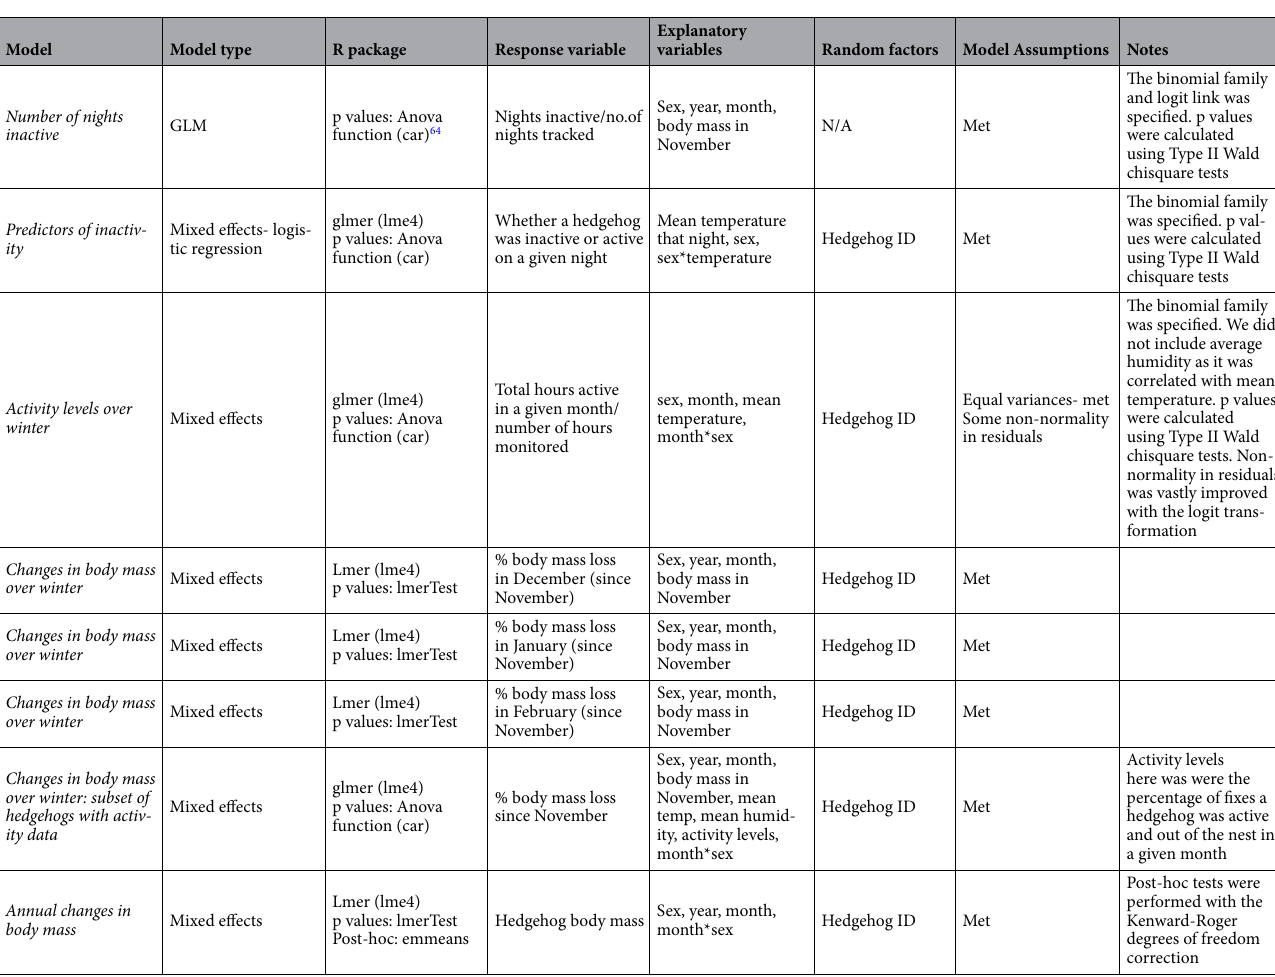
Table 3. The series of models used to test for patterns in hedgehog body mass changes and activity over winter in